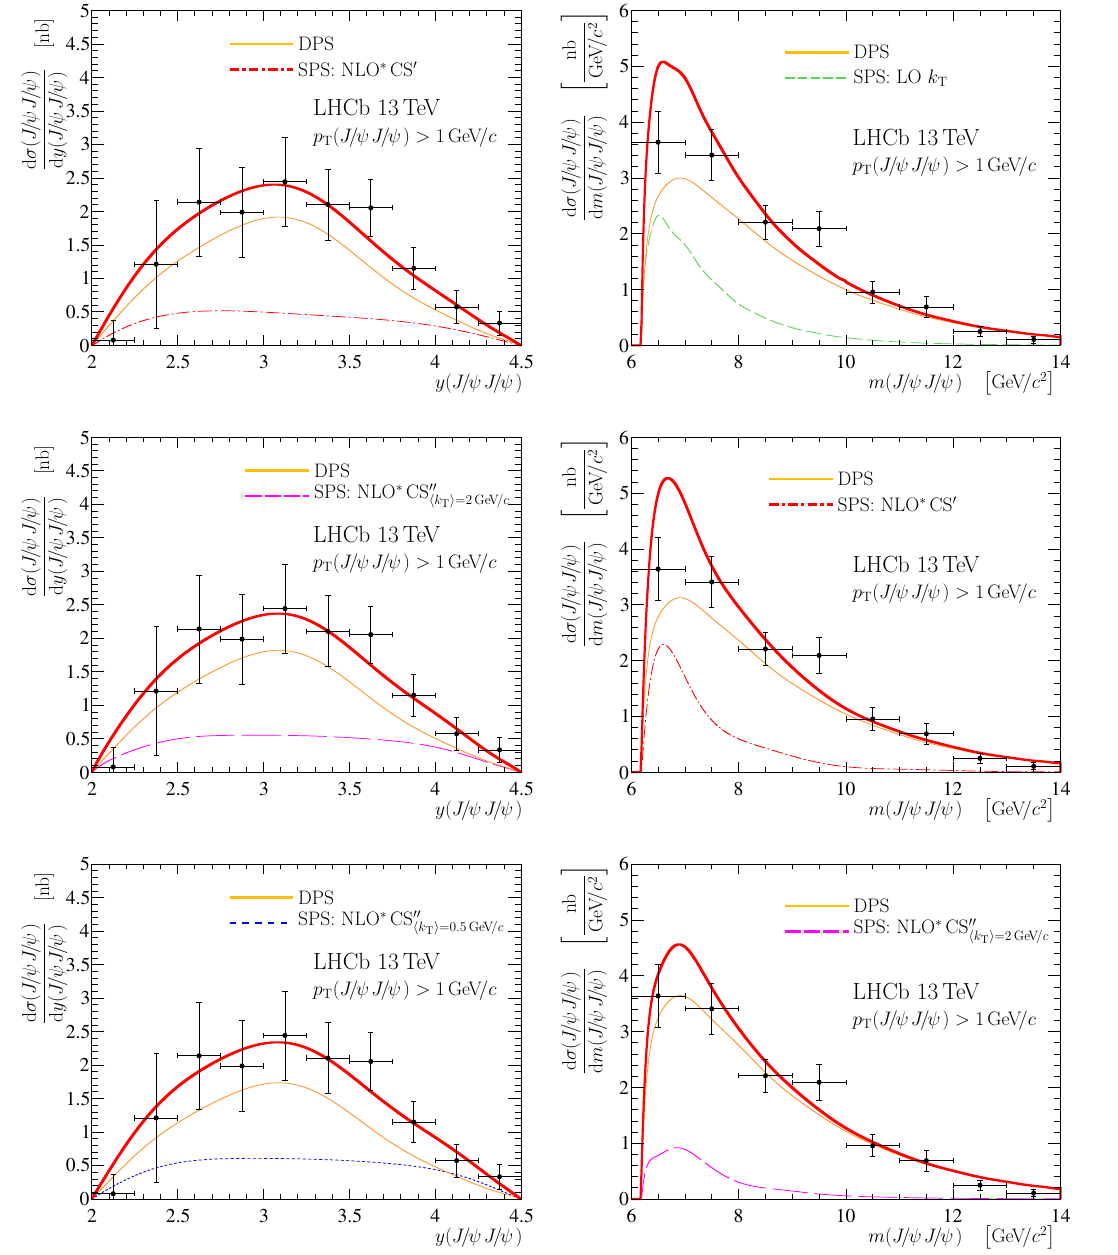
Figure 12. Result of templated DPS (cid:12)t for d (cid:27) ( J= J= ) 1 GeV =c region. The (black) points with error bars represent the data. The total (cid:12)t result is shown with the thick (red) solid line and the DPS component is shown with the thin (orange) solid line.